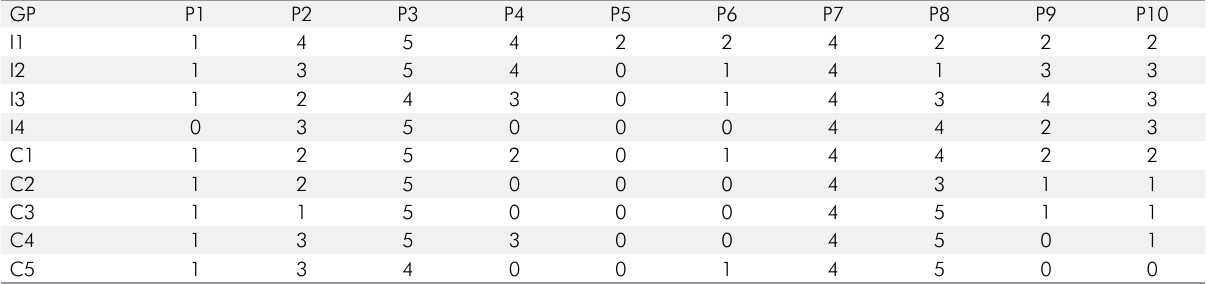
Chart 3. VAS values after each irradiation session and in the five control checkpoints in Control Group expressed according to the categories of